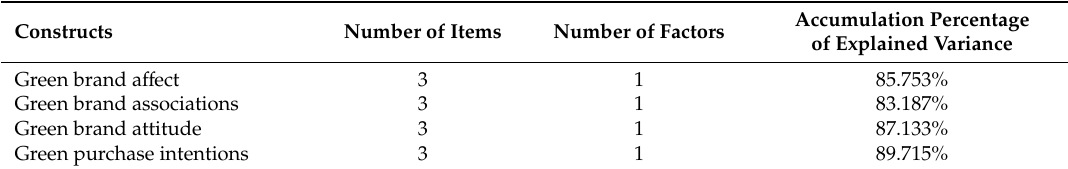
Table 3. Factor analysis of this